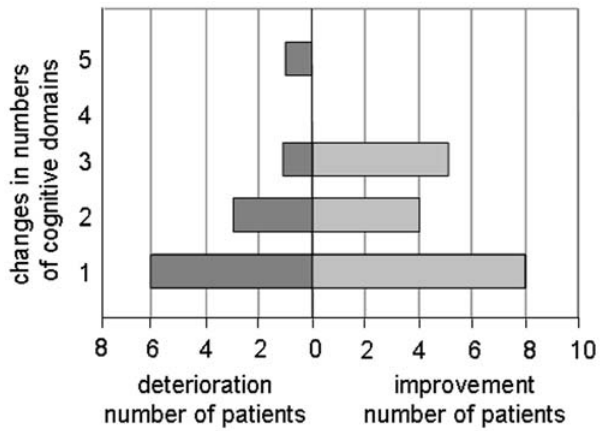
Figure 2. Displayed are the numbers of patients who cogni- tively deteriorated or improved 6 weeks after intervention in